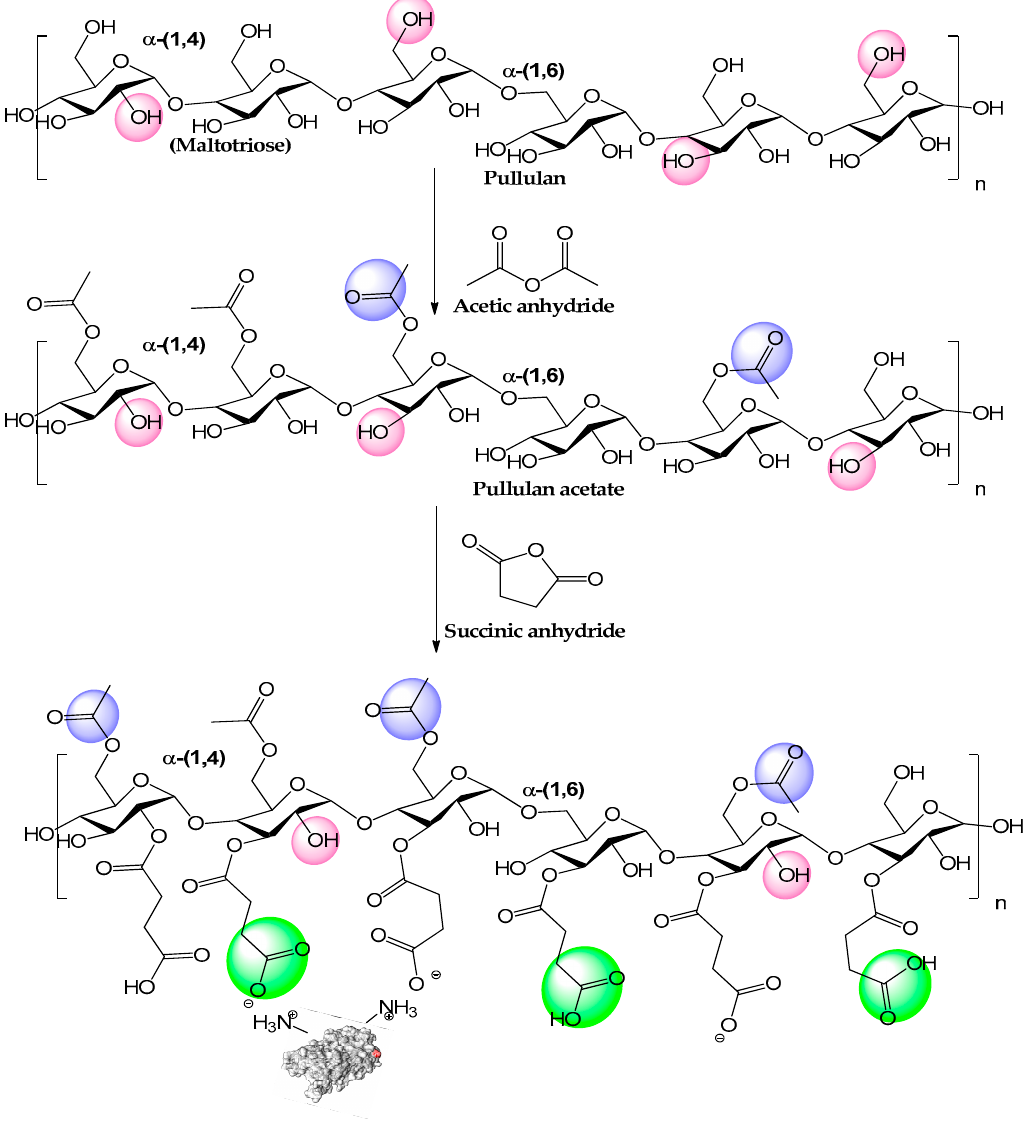
Figure 21. Schematic representation of the chemical structure of succinylated pullulan acetate. The backbone of pullulan is a linear polymer of α -(1,6)-maltotriose.